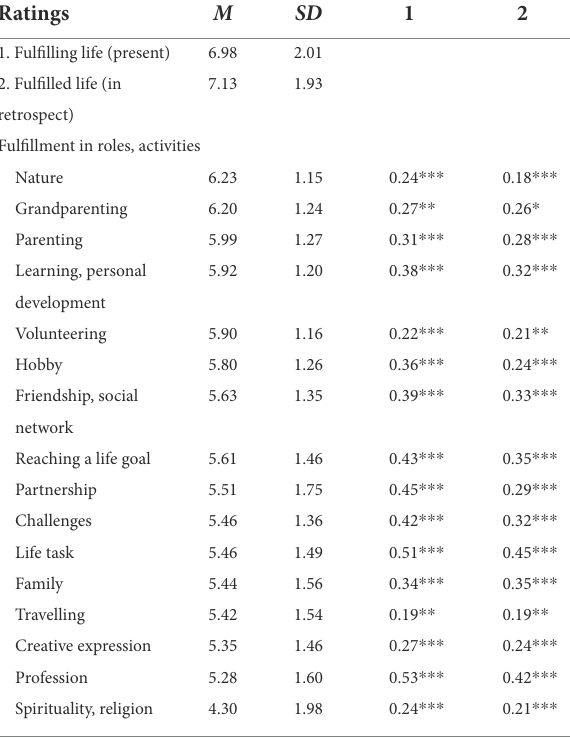
TABLE 2 Descriptive statistics and correlations for fulfilling life and fulfilled life ratings and level of experienced fulfillment in activities and